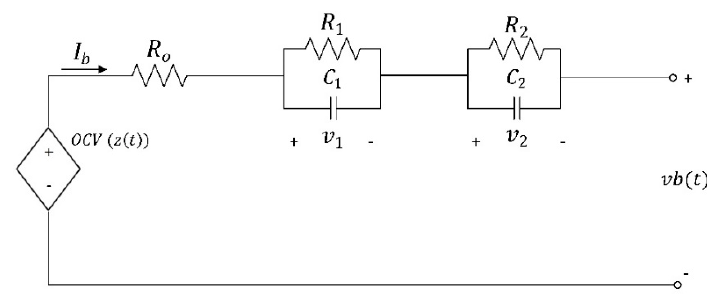
Figure 3. circuit model for lithium ion battery cell.